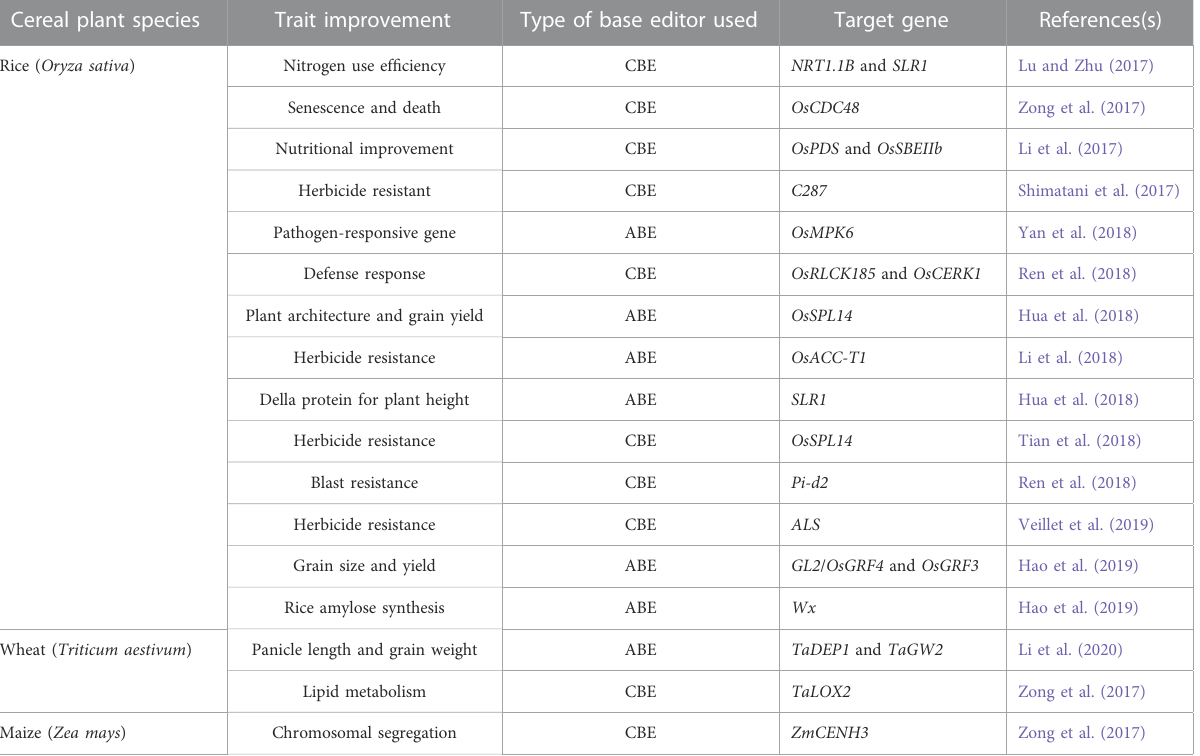
TABLE 3 List of genes targeted by cytidine and adenine base editors in cereal crops. Cereal plant